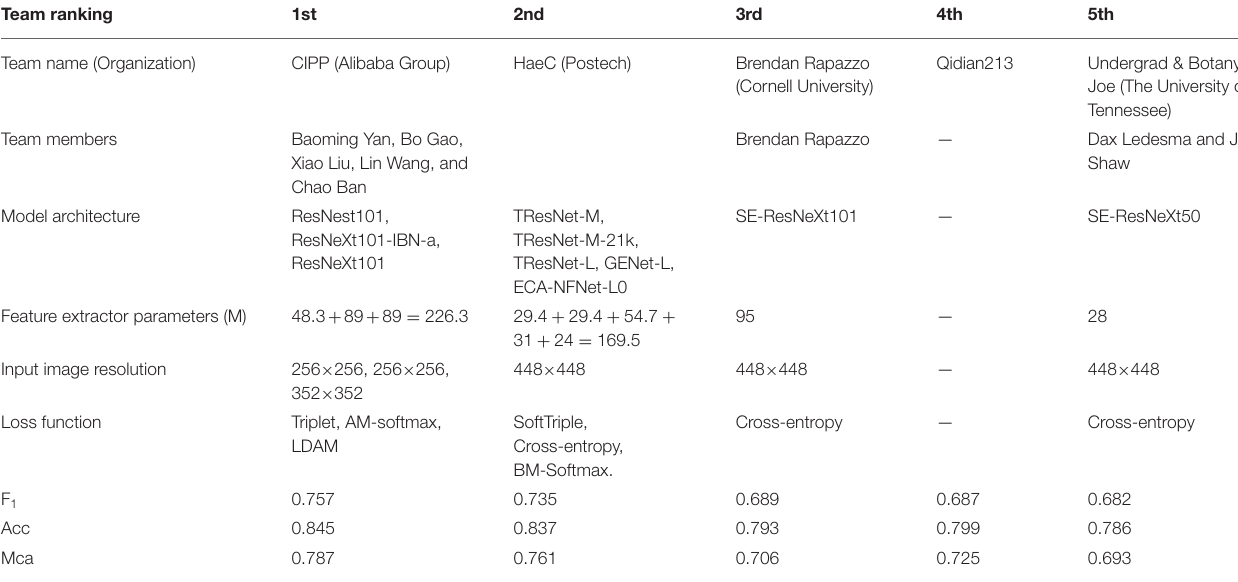
TABLE 2 | Summary of the top competitors’ solutions and performance. Team ranking